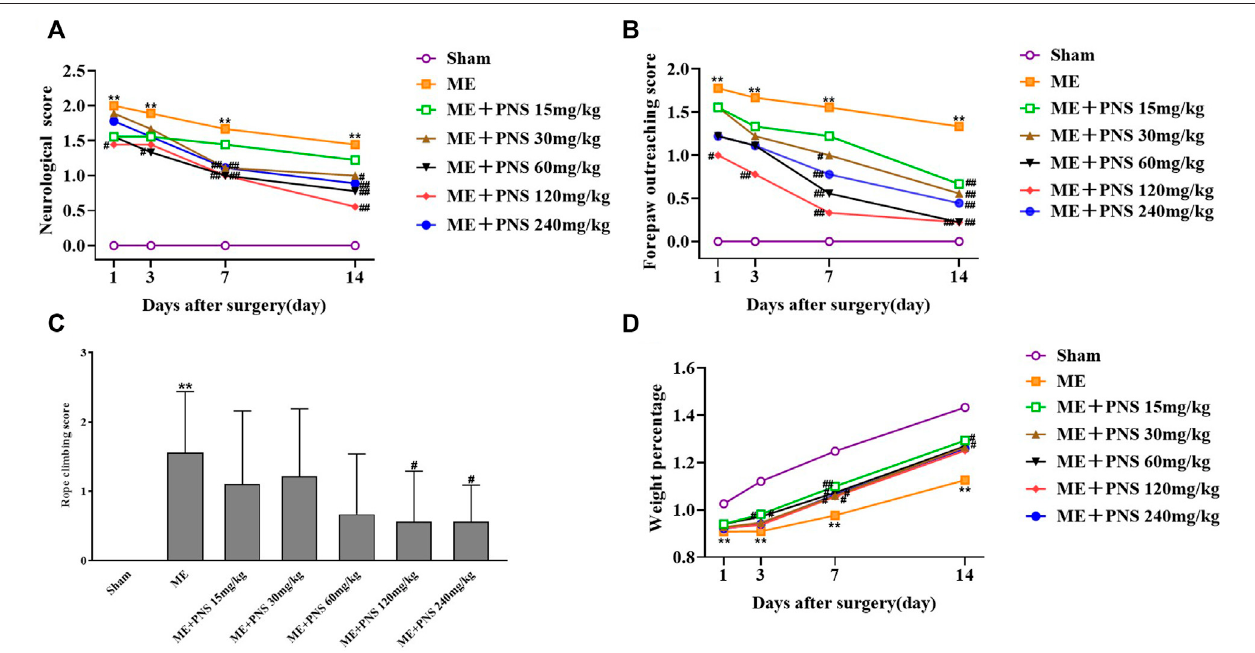
FIGURE 2 | PNS treatment improved the recovery of neurological functions in ME rats. Comparison of neurological score, forepaw outreaching score and weight percentage were measured at day 1, 3, 7, and 14 after ME surgery at different time nodes. Rope climbing test score were detected at day 14 after ME surgery. (A) Neurological score (B) Forepaw outreaching test score (C) Rope climbing test score (D) Weight percentage.The data inexperiment (A,B,D) were shown asmeans and thedatainexperiment (C) werepresentedasmeans±standarddeviation( n =9animalspergroup).* p < 0.05,** p < 0.01versusShamgroup; # p < 0.05, ## p < 0.01 versus ME group.